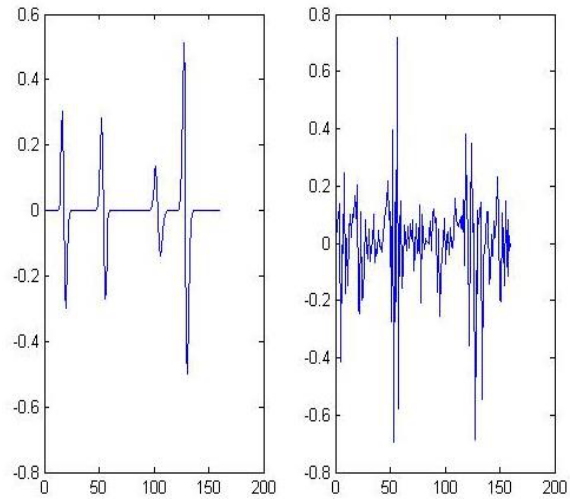
Fig.5: Derivate of Fitted and real data of EX DRA star.